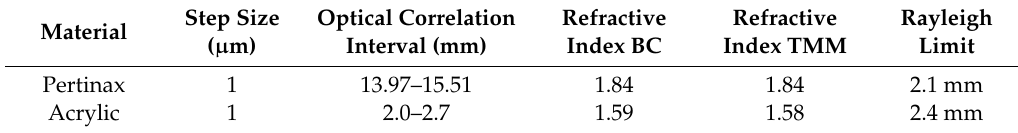
Table 1. Parameters for the evaluation of the refractive index.